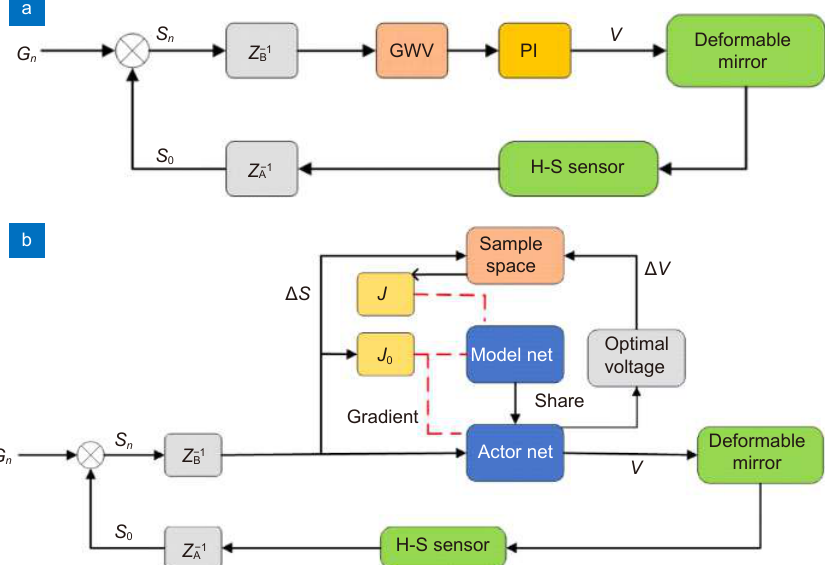
Fig. 22 | Controller for an AOS. ( a ) PI control model; ( b ) DLCM control model. and are the H-S sensor delay and control calculation delay, respectively. GWV (Generating wavefront to voltage). and are the cost functions of the network and the red dotted line is a gradient data stream. Figure reproduced from ref. 104 , Optical Society of